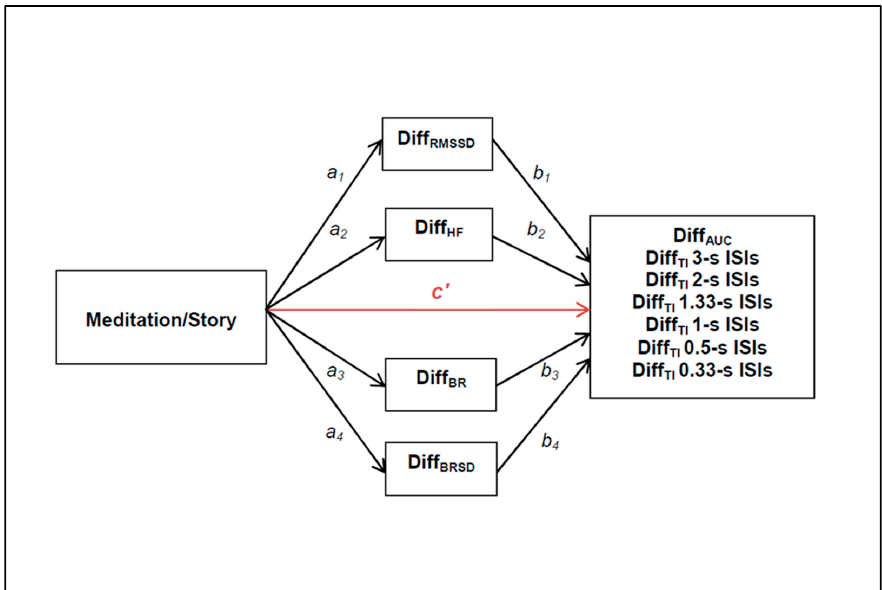
Figure 1. Illustration of the multiple-mediation model applied here. The possible associations between the type of intervention (X: meditation vs. story) and the psychophysical variables (Y: Di ff AUC , Di ff TI 3 s ISI, Di ff TI 2 s ISI, Di ff TI 1.33 s ISI, Di ff TI 1 s ISI, Di ff TI 0.5 s ISI, Di ff TI 0.33 s ISI), either directly ( c ’ path in red color ) or through the physiological mediating variables ( a i b i paths; Di ff RMSSD , Di ff HF , Di ff BR , Di ff BRSD ), are pictured with arrows.